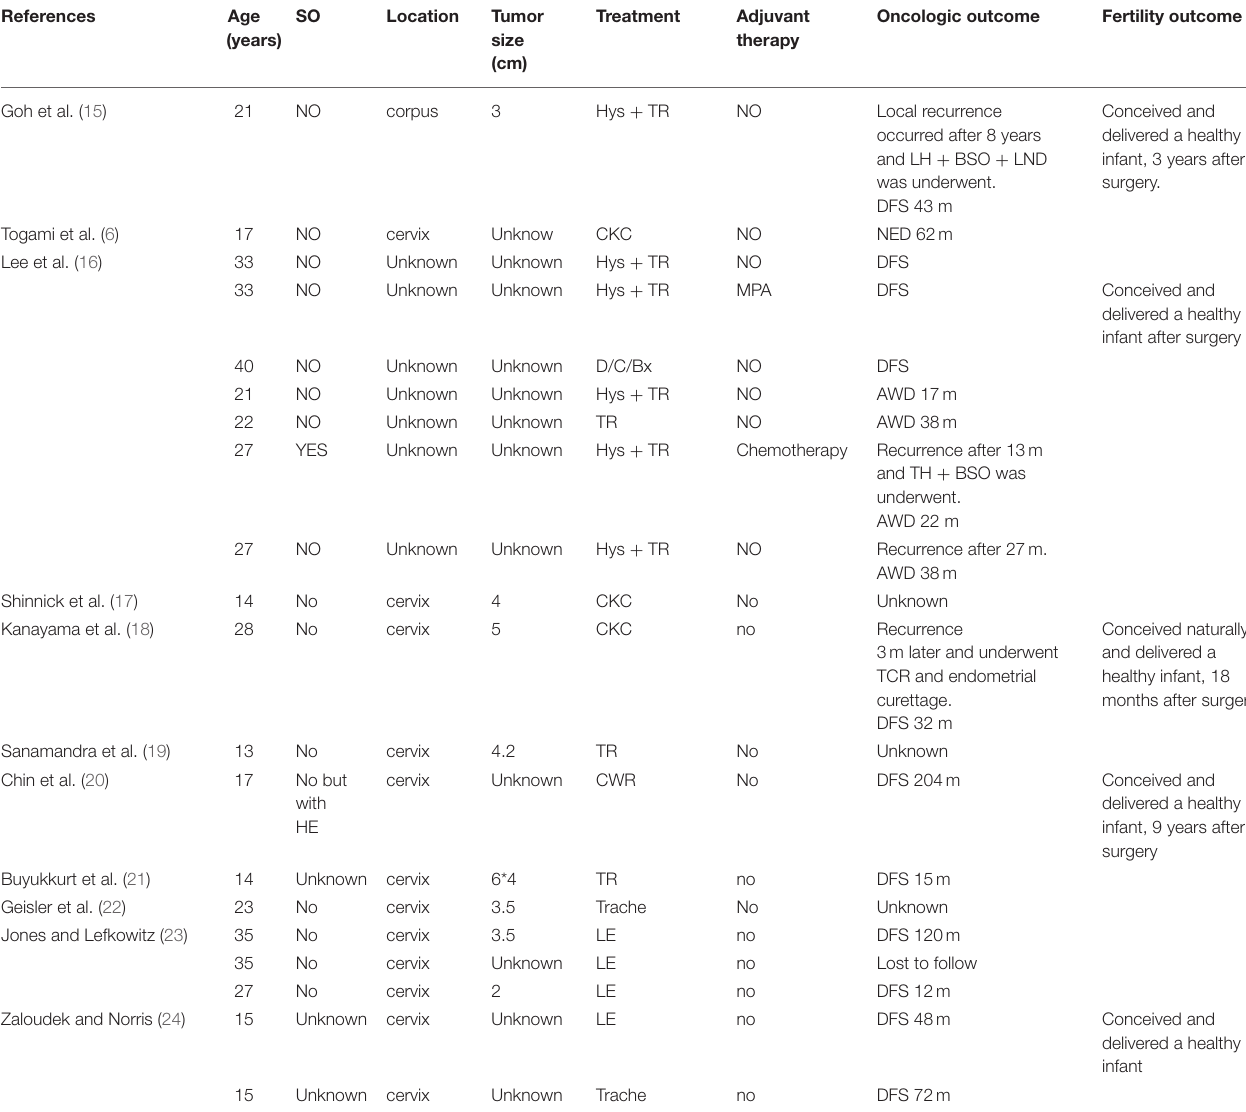
TABLE 2 | Review of literatures about fertility-sparing surgery in uterine adenosarcoma.